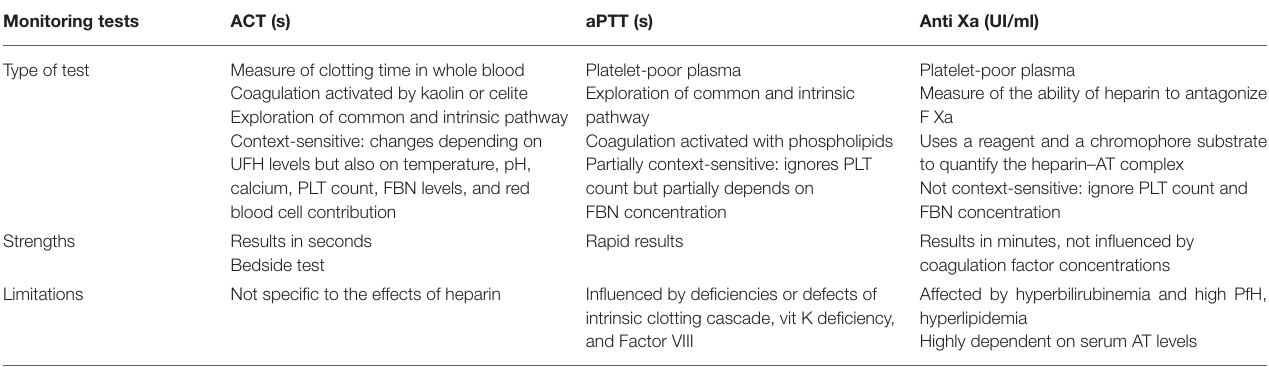
TABLE 3 | Characteristics of conventional coagulation